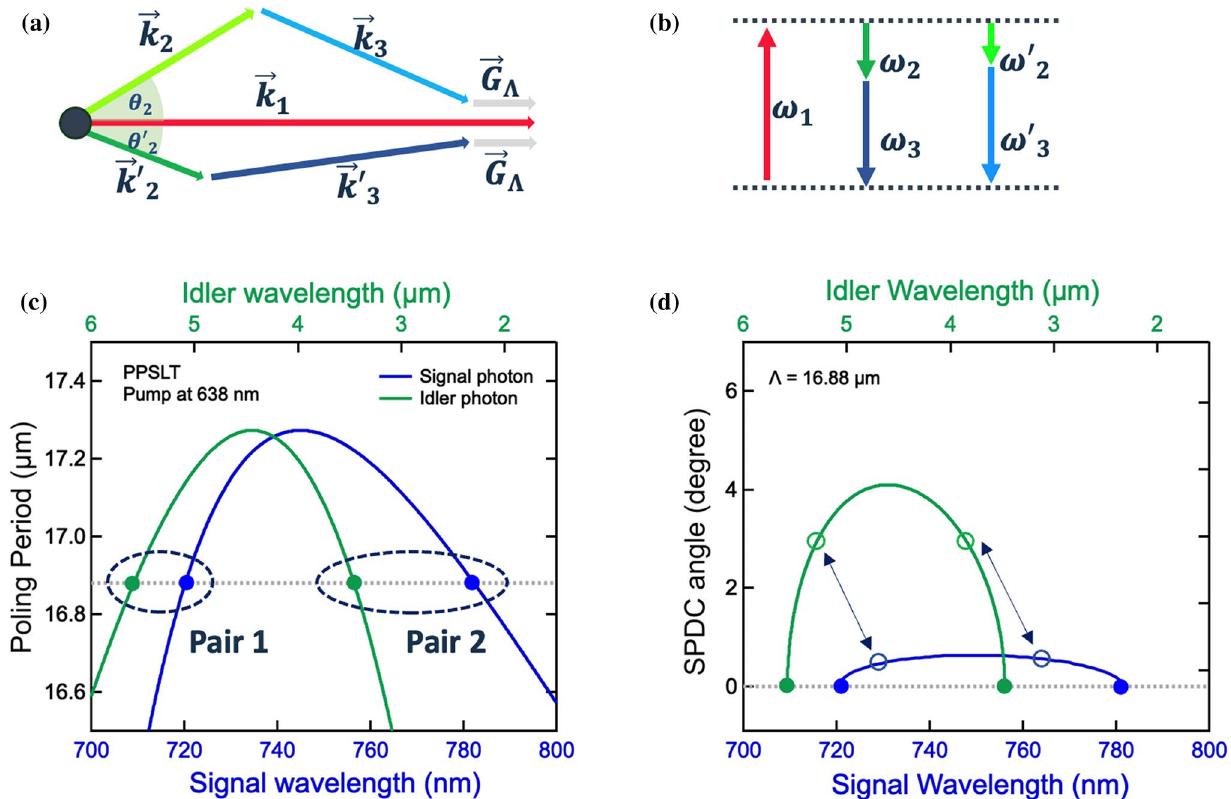
Figure 2. Schematic diagrams and theoretical simulations of quasi-phase-matching condition. ( a ) Conservation law for wave vectors in SPDC. Two signal-idler pairs phase-matched for the same pump and −→ −→ G G (cid:31) . The poling superlattice vector (cid:31) is assumed to be parallel to the pump wave vector. ( b ) Energy diagram of related photons for SPDC in the crystal. ( c ) Relation between the poling period of the crystal and SPDC wavelengths for the pump at 638 nm. The bottom axis represents the SPDC signals (blue curve) and the top the SPDC idlers (green curve). With the periodicity of 16.88 µm, two pairs (Pair 1: 720 nm and 5.6 µm. Pair 2: 780 nm and 3.5 µm) are simultaneously quasi-phase-matched in the same condition. ( d ) Dependency of the emission angle of the SPDC signals and idlers on their wavelengths. The vertical axis represents the SPDC output angle. The dashed circles indicate the collinear process ( c ) and double arrows indicate the non-collinear process in the case of the idler angle of